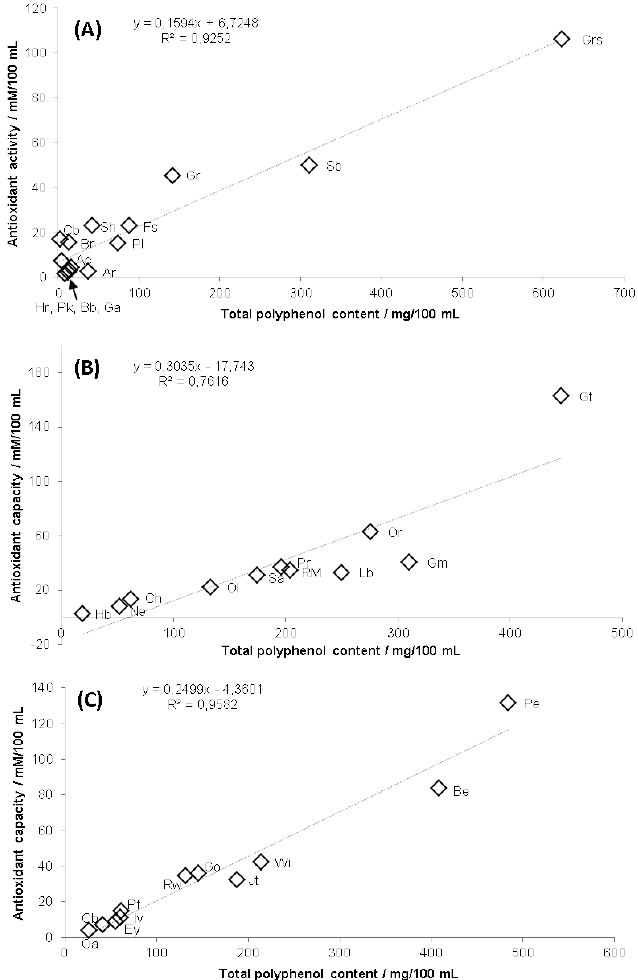
Fig. 2: Linear correlation of total polyphenol content (mg/100 mL) and antioxidant capacity (mM/100 mL). Fresh-cut apple samples